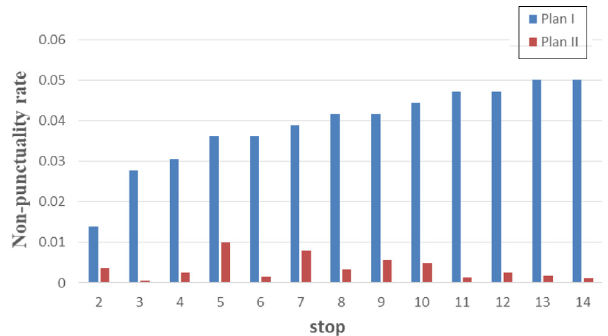
Figure 4 Comparisons of non- punctuality rate under two plans